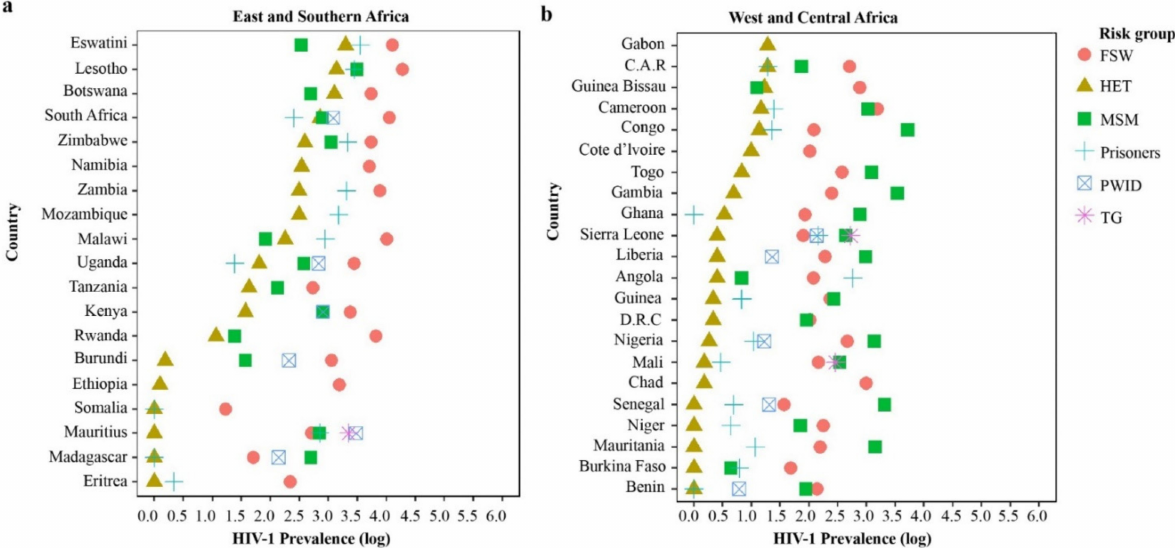
Figure 3. HIV-1 prevalence in different risk groups in sub-Saharan Africa (sSA). A comparison of national estimates of HIV-1 prevalence in the heterosexuals (HET) and among vulnerable populations in sSA as reported by UNAIDS in 2020 (https://aidsinfo.unaids.org/ (accessed on 20 January 2021)). East and Southern African ( a ), and West and Central African ( b ) regions were grouped together, respectively. The countries in each region were arranged in increasing HIV-1 prevalence among (HET), and HIV-1 prevalence data have been transformed into a log scale on the x-axis. Different risk groups are coloured as shown in the legend (Red: female sex workers; Brown: HET; Green: men having sex with men; Sky Blue: prisoners; Dark Blue: PWID; and Pink: transgender